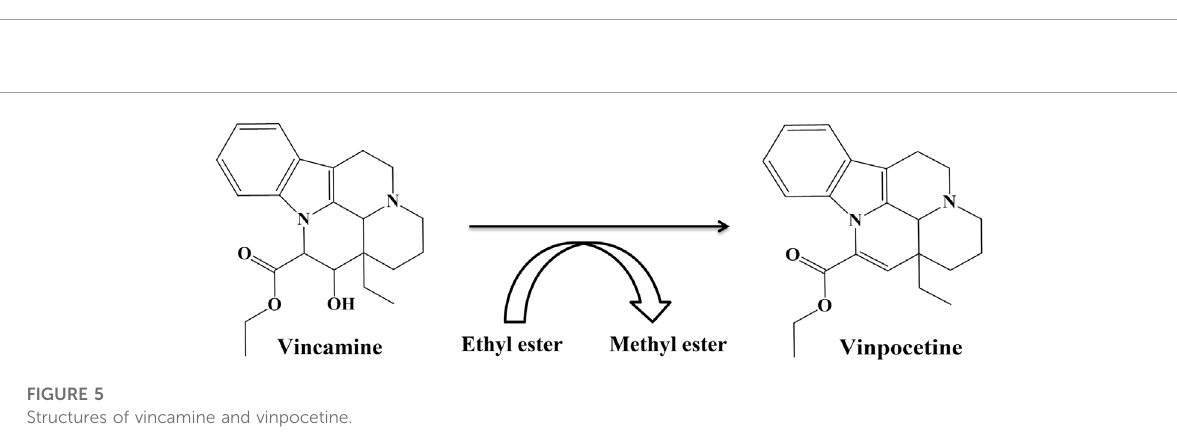
Pathophysiologyofcognitivedecline.ATP=Adenosinemonophosphate,GTP=Adenosineguanosinemonophosphate,AC=Adenylylcyclase, GC=Guanylyl,PDE1=Phosphodiesterase-1,3 ʹ ,5 ʹ -cAMP=3 ʹ ,5 ʹ -cyclicadenosinemonophosphate,5 ʹ -cAMP=5 ʹ -cyclicadenosinemonophosphate. ↑ , increased sign; ↓ , decreased sign.